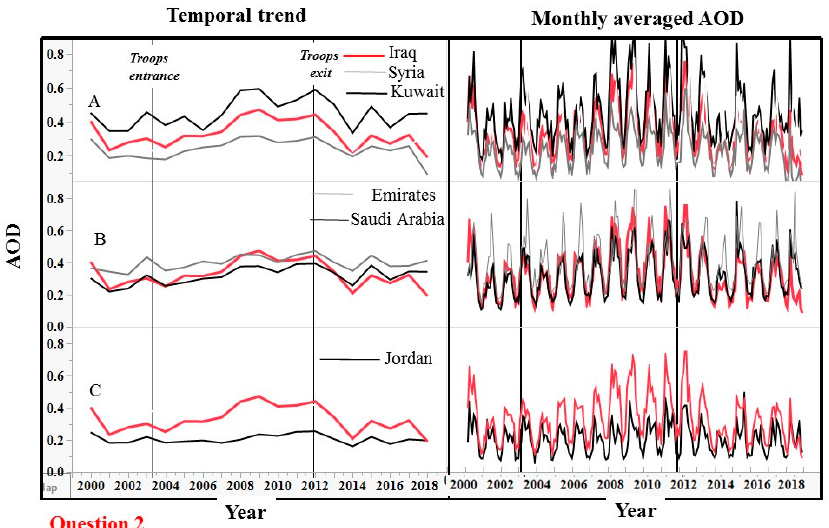
Figure 2. Comparison of monthly average AOD values between Iraq and adjacent countries. Left: smoothed average AOD, right: monthly average AOD. Iraq, Kuwait ( A ) and Saudi Arabia ( B ) show a similar increasing trend. Whereas the amplitude is larger for Kuwait, the amplitude for Iraq is larger than that for Saudi Arabia. However, the decrease in AOD between 2012 and 2018 is largest for Iraq. Iraq AOD pattern differs from those of Jordan and Syria ( A,C ). The data was generated using an open source engine Giovanni at 1 ° spatial resolution (https://giovanni.gsfc.nasa.gov/giovanni/doc/UsersManualworkingdocument.docx.html).